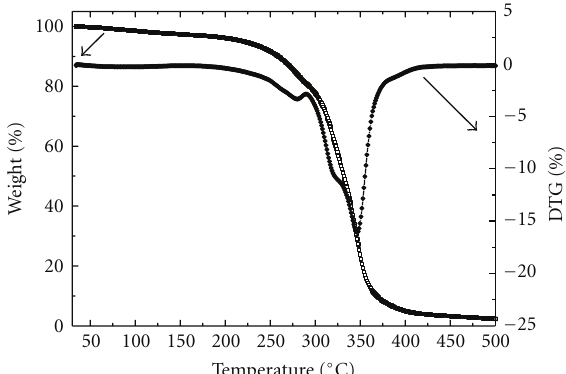
Figure 1: Thermogravimetric analysis curves of HEEDAI.